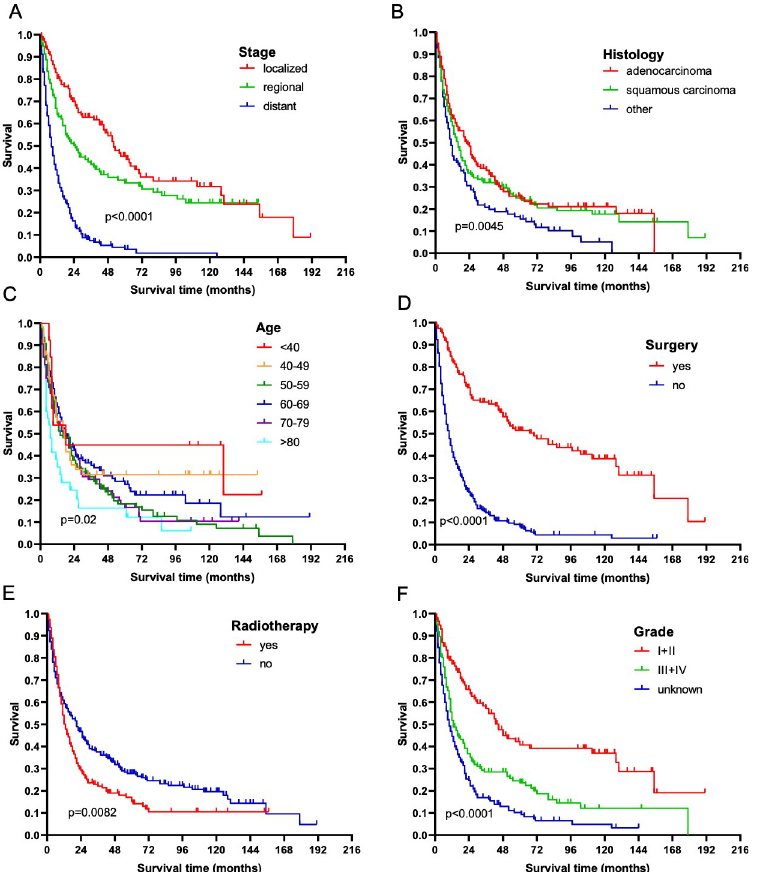
Fig 2. Influence of stage, pathological type, age, surgical records, radiotherapy records, and differentiation grade on OS in CC-NSCLC. (A) Kaplan–Meier survival curves indicated that the mOS of patients with CC-NSCLC having localized, regional, and distant staging was 52.0, 25.0, and 8.0 months, respectively ( P < 0.0001). (B) Kaplan–Meier survival curves indicated that the mOS of patients with CC-NSCLC having adenocarcinoma, SCC, and other was 22.0, 16.0, and 11.0 months, respectively ( P < 0.01). Kaplan–Meier survival curves indicated the following: (C) young patients with CC-NSCLC had superior OS compared with patients older than 80 years ( P < 0.05); (D) patients with CC-NSCLC who underwent surgical resection had significantly longer survival compared with those who did not undergo resection (70 months vs 10 months; P < 0.0001); (E) patients with CC-NSCLC who underwent radiotherapy had significantly shorter survival compared with those who did not undergo radiotherapy (13 months vs 21 months; P < 0.01); and (F) the mOS of patients with CC-NSCLC having grade I + II, grade III + IV, and unknown differentiation was 45, 13, and 10 months, respectively ( P < 0.0001).